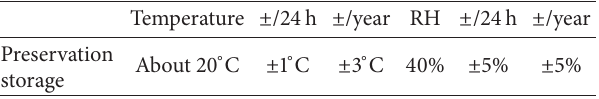
Table 5: Recommended climatic storage parameters for optical media.